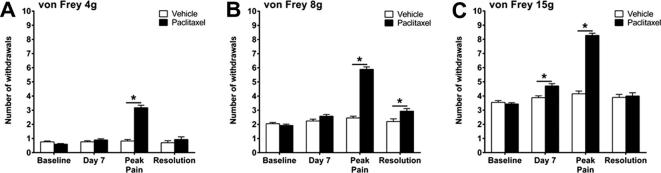
Time course of paclitaxel-induced mechanical hypersensitivity. Graphs show the mean ± SEM of the number of withdrawal responses to (A) 4g, (B) 8g and (C) 15g von Frey filaments at; baseline, day 7, peak pain (day 23–31) and pain resolution (day 173–220), following paclitaxel/vehicle administration at days 0, 2, 4 and 6. *p < 0.05, two-tailed multiple comparison unpaired t-tests with Holm-Sidak correction. Day 7 n = 108 vehicle, n = 114 paclitaxel; peak pain n = 73 vehicle, n = 75 paclitaxel; resolution n = 30 vehicle, n = 30 paclitaxel. NB: These data are compiled from several cohorts of animals used to generate tissues for these studies. Data from each individual cohort show no significant difference in mechanical hypersensitivity, between vehicle and paclitaxel-treated animals, at day 7 and pain resolution.